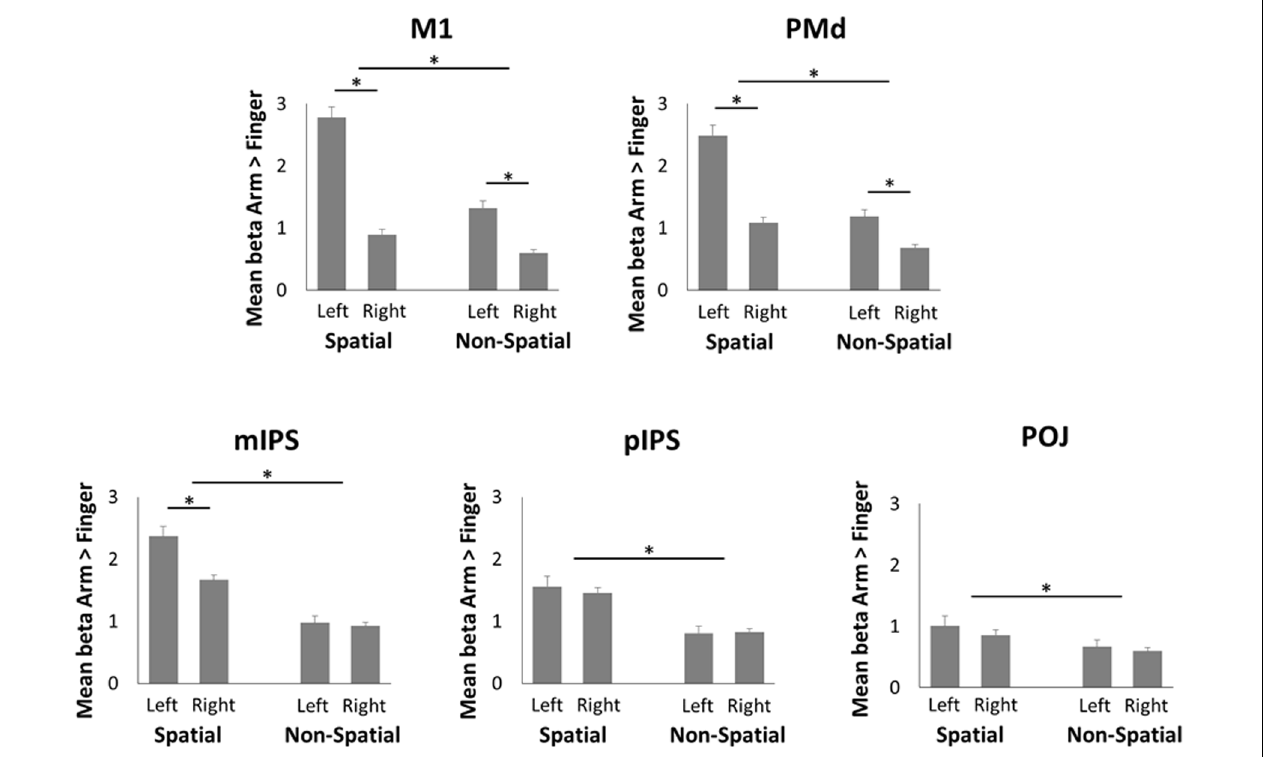
FIGURE 4 | Region of interest (ROI) analysis in the fMRI experiment. Mean beta values during Spatial reach planning (Spatial Arm > Spatial Finger) and Non-Spatial reach preparation (Non-Spatial Arm > Non-Spatial Finger) in bilateral M1, PMd, mIPS, pIPS, and POJ. Asterisks denote a significant difference at p < 0.05.